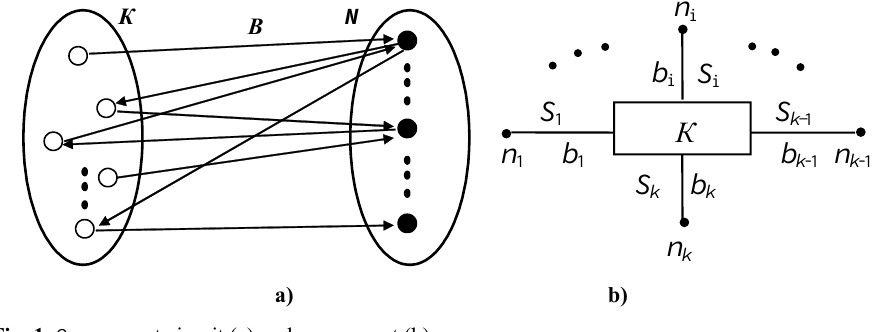
Fig. 1. C omponent circuit (a) and component